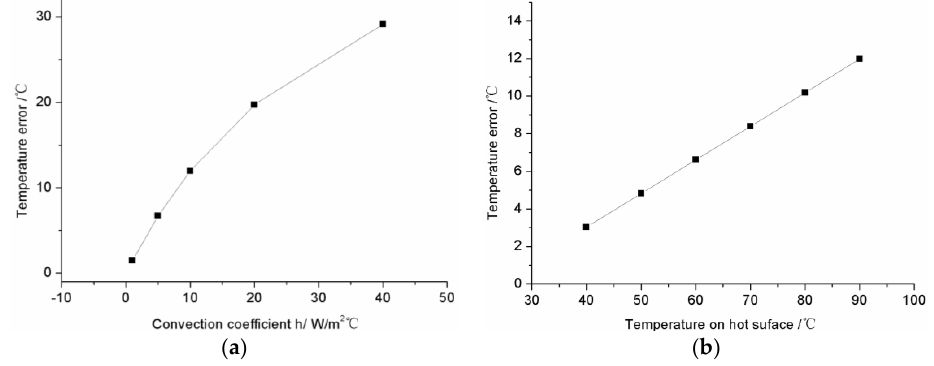
Figure 4. Measurement error numerical analysis of FBG Sensor. ( a ) The influence of convection on temperature error; ( b ) The influence of temperature difference between surrounding and hot surface on temperature error.